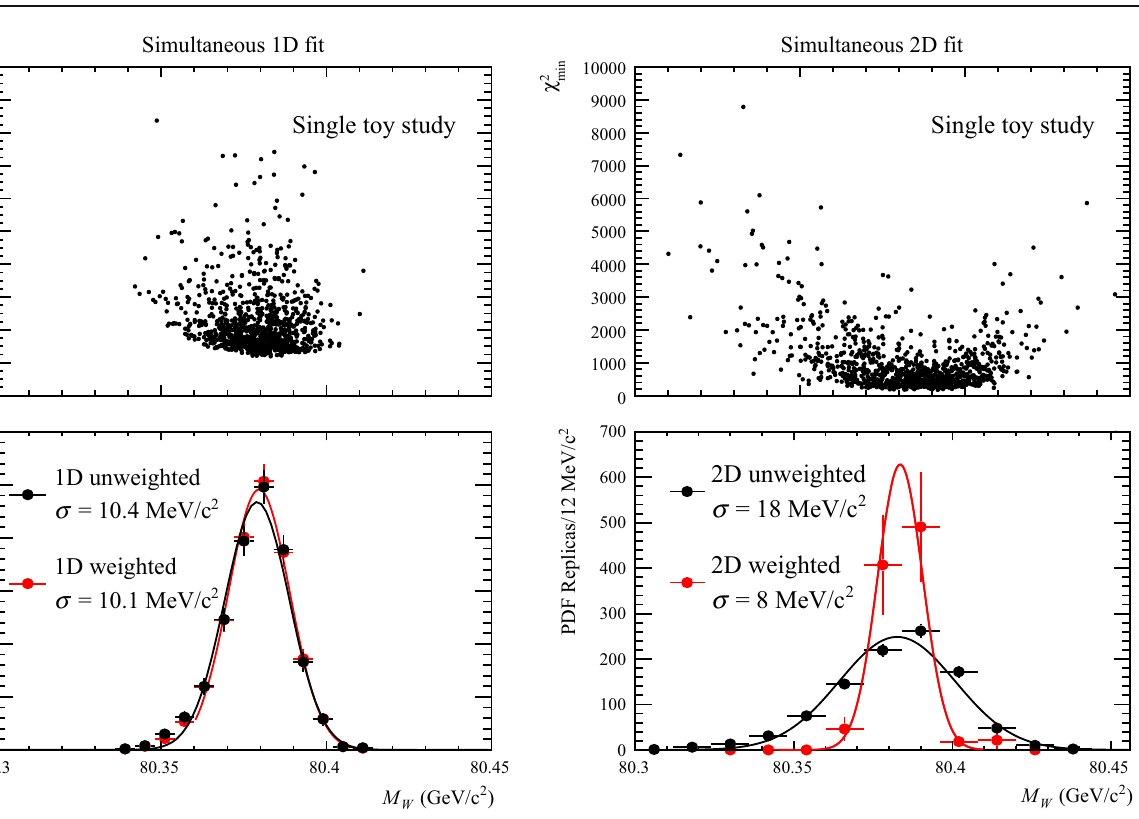
fit function overlaid, without (black) and with (red) weighting. In the simultaneous fit the W + and W − templates share the same normalisa-